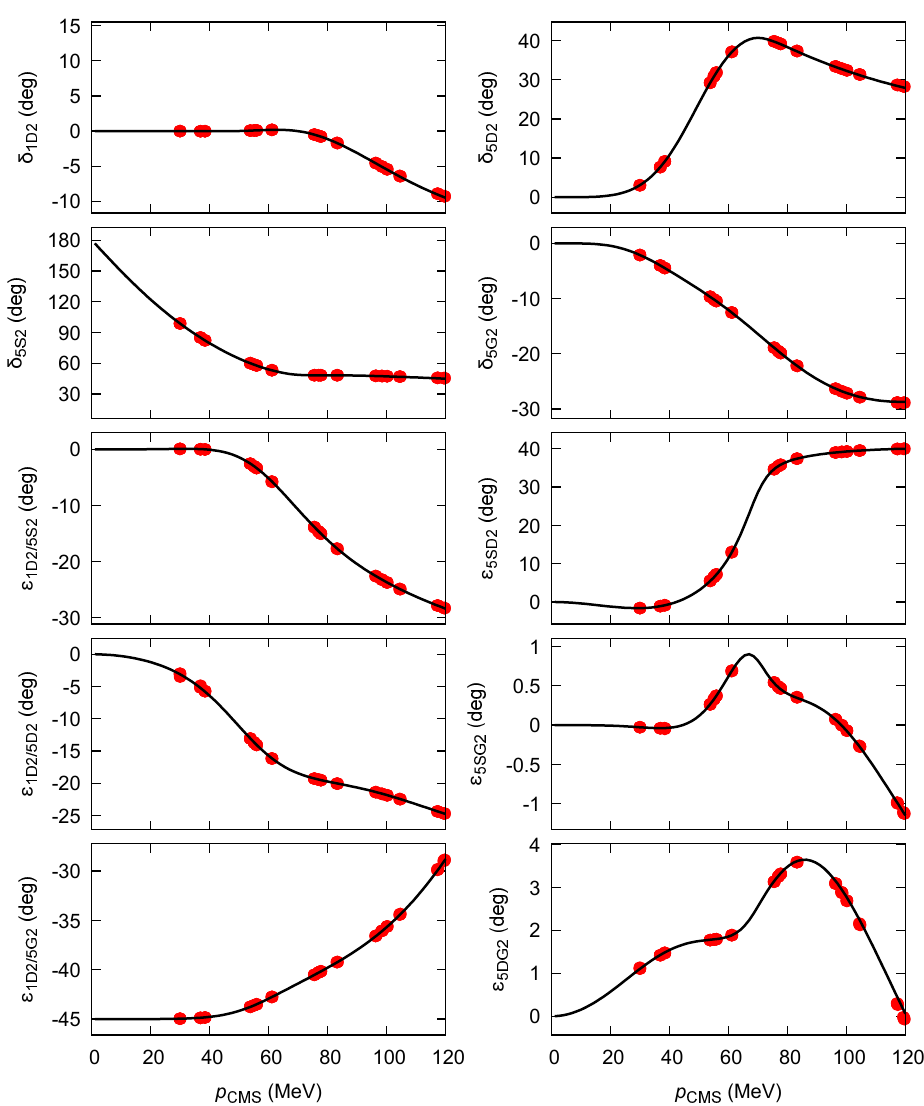
/ 5 SDG -wave (black solid line: 2 2